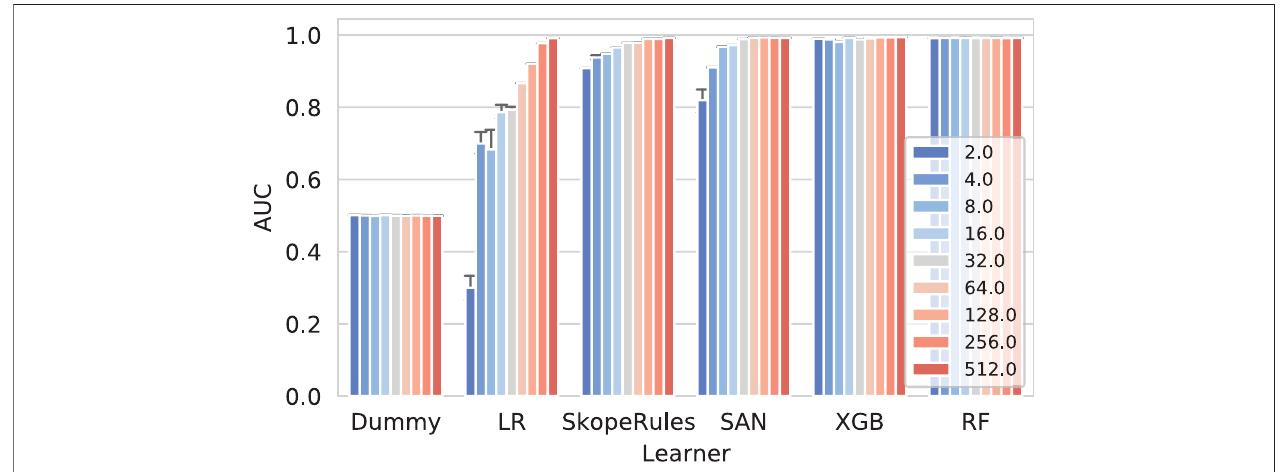
FIGURE 4 | Network reconstruction benchmark results for individual learners. The more complex classi fi ers such as the self-attention networks (SAN), extreme gradient boosting (XGB), and Random Forests perform well when considering different amounts of training data (10, 50, and 90%). On the contrary, the logistic regression classi fi er (LR) performs adequately (AUC65) only if enough data were used. The impact of the embedding dimensionality can also be observed. Only high- enough dimensions result in good predictive performance, consistently for all